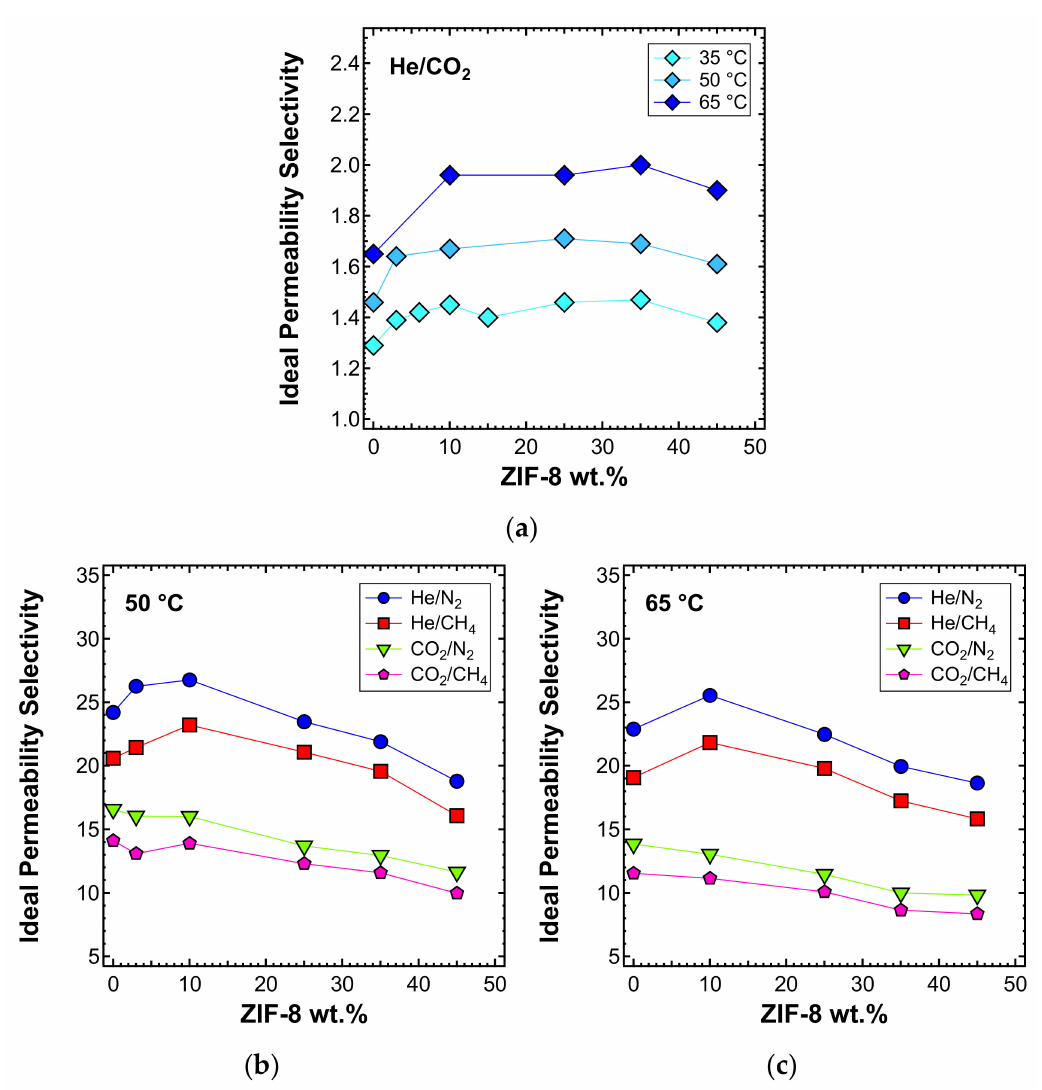
Figure 13. Ideal selectivity for ( a ) He / CO 2 at 35, 50, and 65 ◦ C and other gas couples at ( b ) 50 and ( c ) 65 ◦ C in ZIF-8 / PPO MMMs, with an upstream pressure of 1.3